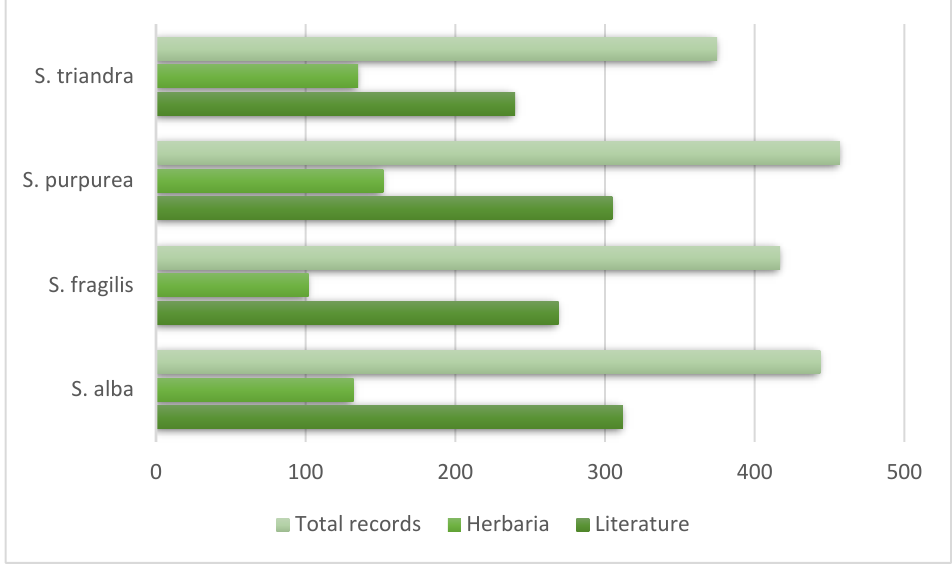
Figure 1. Number of Salix species records.